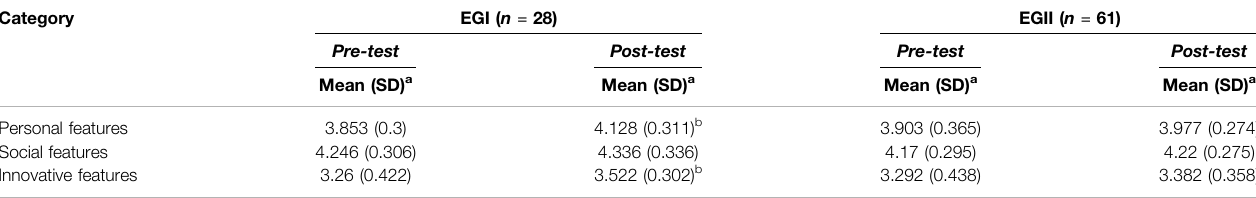
TABLE 2 | Pre-test/Post-test categories comparison in each group. Category EGI ( n = 28) Pre-test